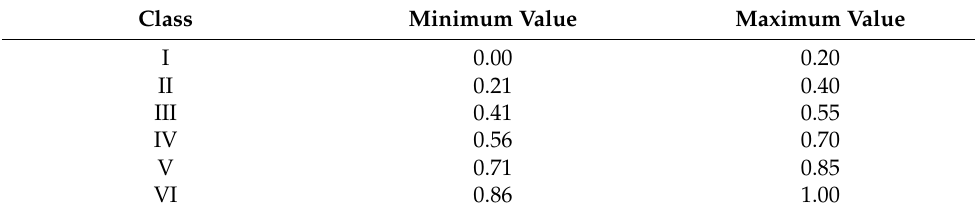
Table 2. Index of structural response: categories and values.